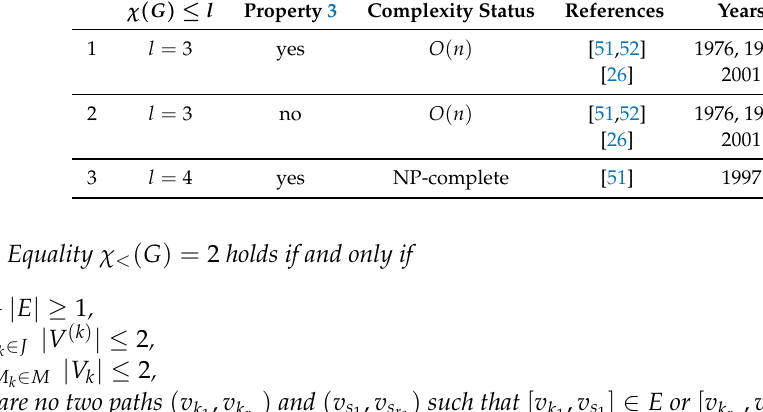
Table 4. The complexity of a mixed graph coloring with short paths and small cliques. χ ( G ) ≤ l Property